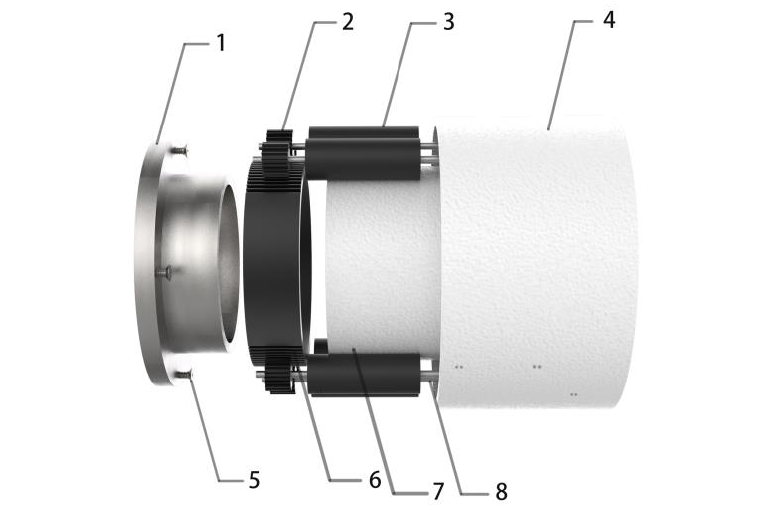
Figure 5. Improved design of stroller safety experience.